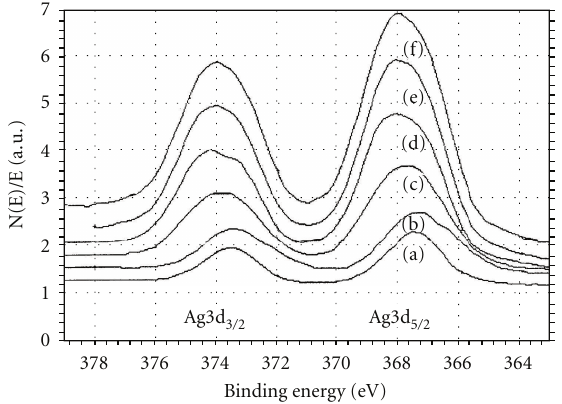
Figure 1: The in situ XPS spectra of Ag3d 3 / 2 and Ag3d 5 / 2 from ion-exchanged glass at various sample temperatures: (a) 20 ◦ C,